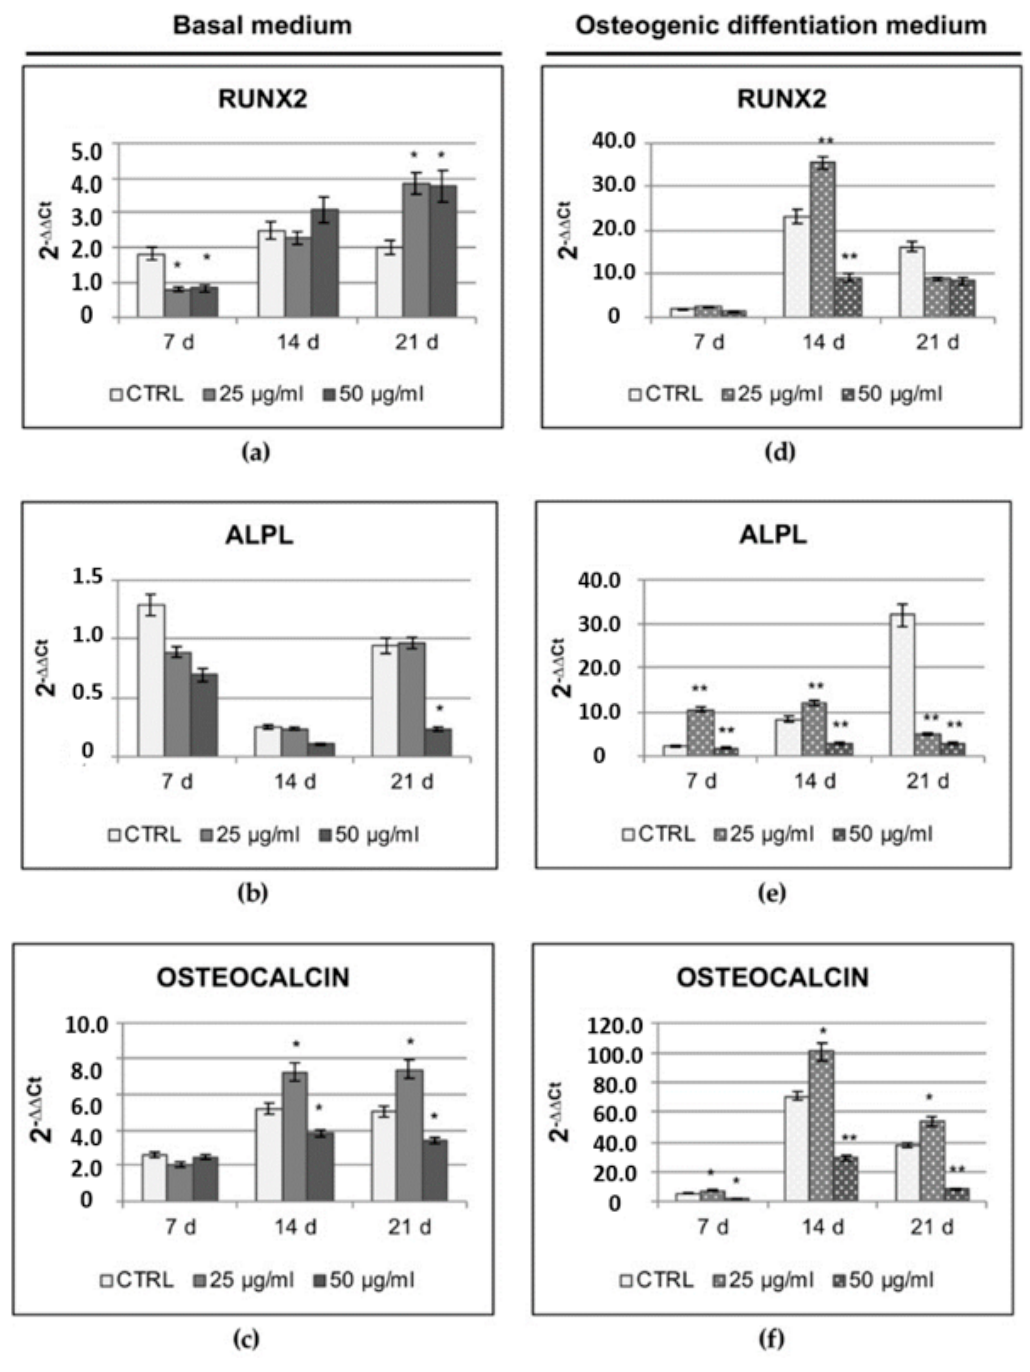
Figure 3. Gene expression of osteogenic markers. ( a – c ) Gene expression of Runt-related transcription factor 2 (Runx2), alkaline phosphatase (ALPL) and osteocalcin (OC) in control ADSCs and ADSCs treated with 25 μ g/mL or 50 μ g/mL of YB at 3, 7, 14 and 21 d of culturing in basal medium. ( d – f ) Gene expression of Runx2, ALPL and OC in control ADSCs and ADSCs treated with 25 μ g/mL or 50 μ g/mL of YB at 3, 7, 14 and 21 d of culturing in osteogenic differentiation medium. * p < 0.05; ** p < 0.01 vs. CTRL.